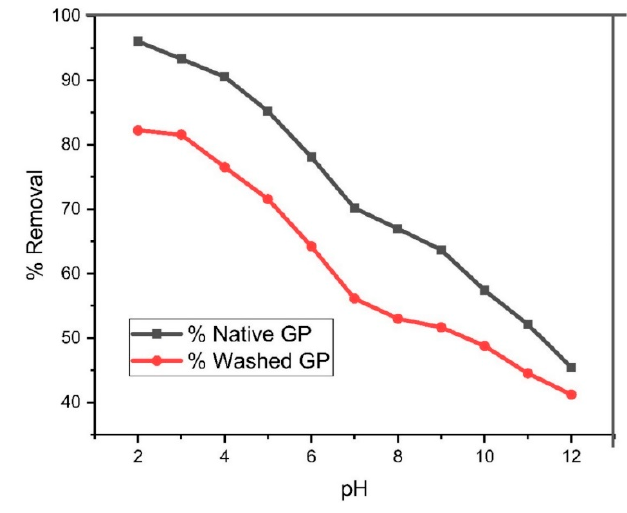
Figure 3. Effect of pH on the removal of EBT.